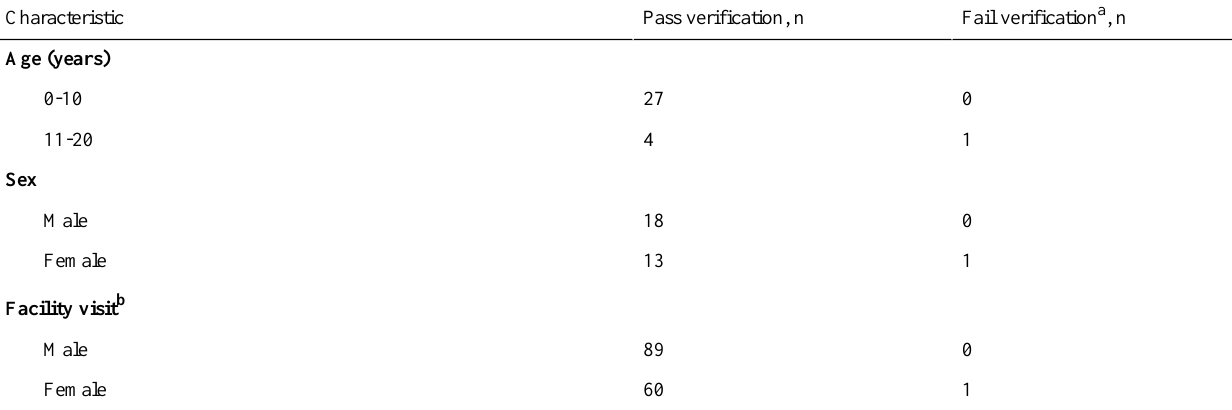
Table 2. Number of inpatient verification trial